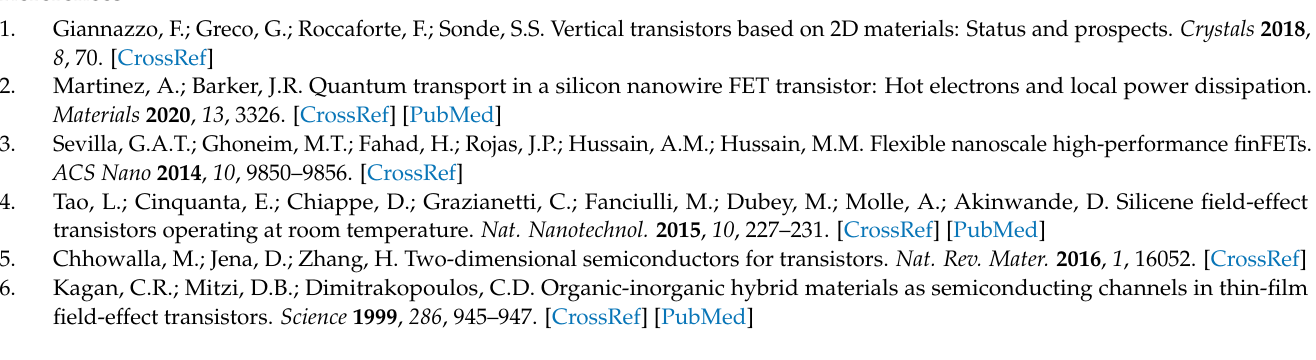
Figure 9. I–V characteristic of (C 4 H 9 NH 3 ) 2 PbBr 4 2D perovskite under different light exposure condi- tions.